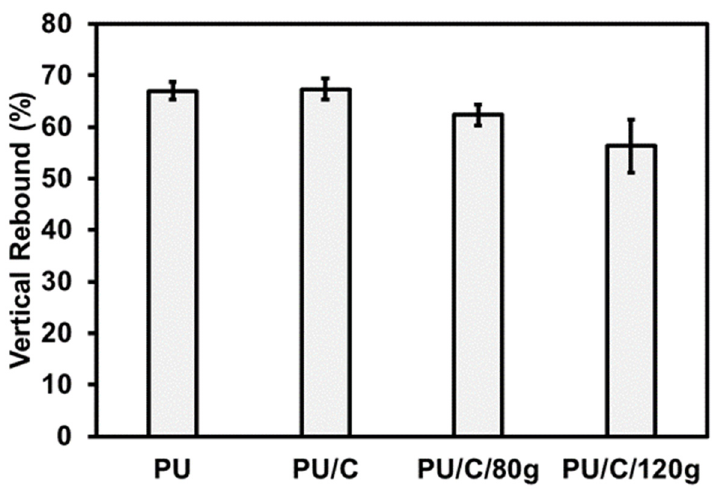
Figure 8. Vertical rebound rate of PU foam composite